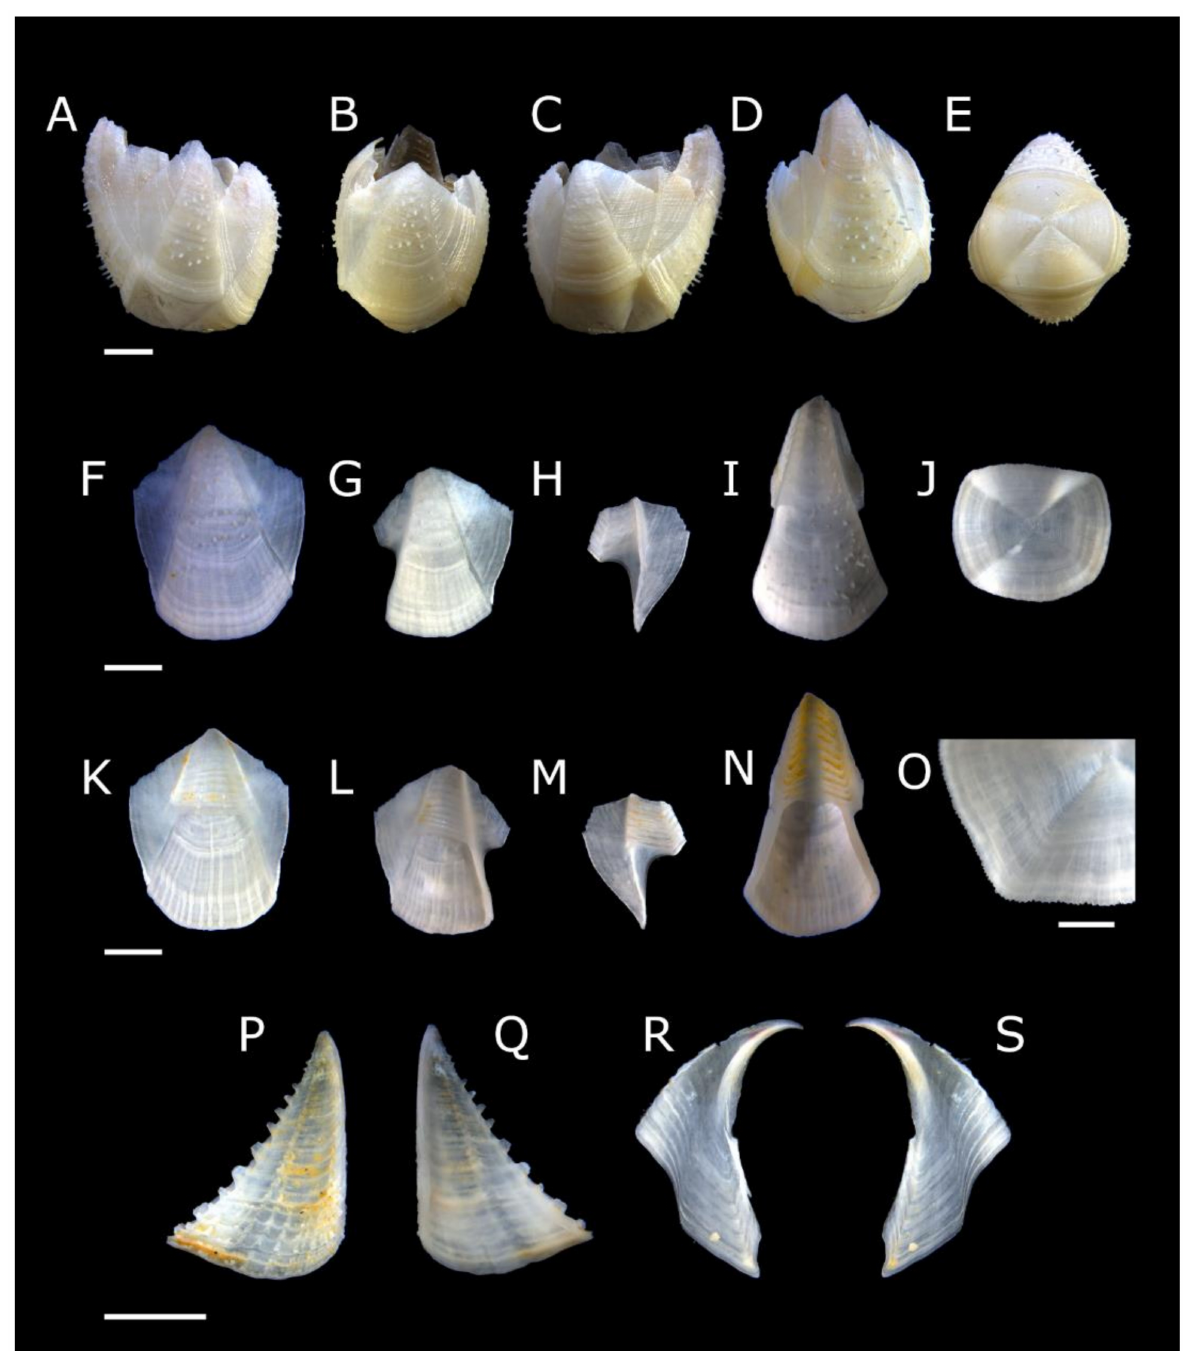
Figure 13. Euacasta excoriatrix sp. nov. shell and shell plates (all WAM C71800). ( A – E ) left, rostral, right, carinal and basal views, respectively, of whole shell; ( F – J ) external view of rostrum, right latus, right carinolatus, carina, and basis, respectively; ( K – N ) internal view of rostrum, right latus, right carinolatus and carina, respectively; ( O ) close up of basal rim; ( P , Q ), external and internal view of right scutum; ( R , S ), internal and external view of right tergum. Scale bars: A–N, P–S = 2 mm; O = 1